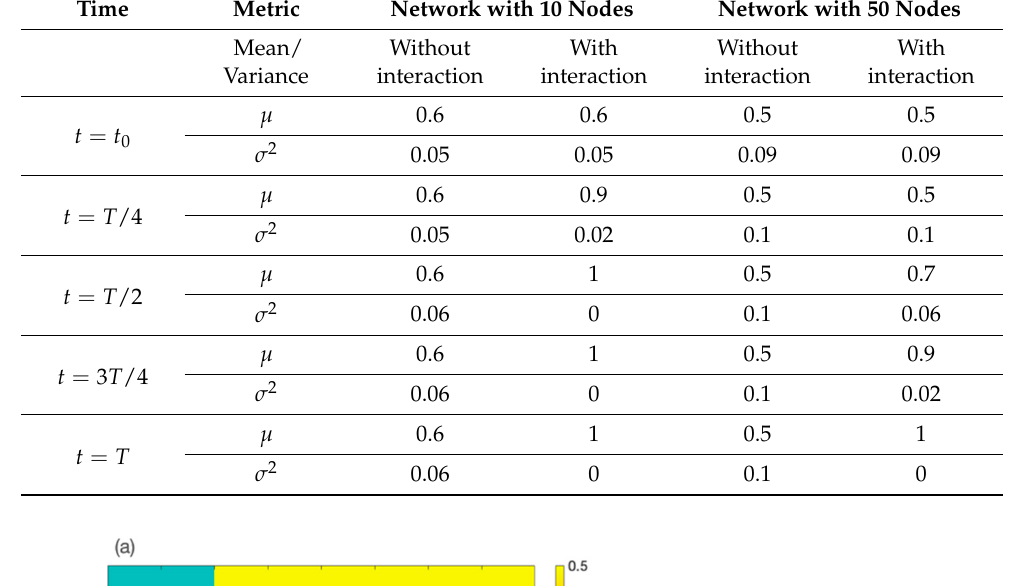
Table 1. Statistical comparison of the model simulations developed for the two networks of Figure 2. The mean and the variance of the simulations without (Figure 3c,d) and with (Figure 3e,f) interactions are evaluated at equally spaced time instants, from the initial time t 0 to the final time T . The values reported in the table are approximated to two digits.